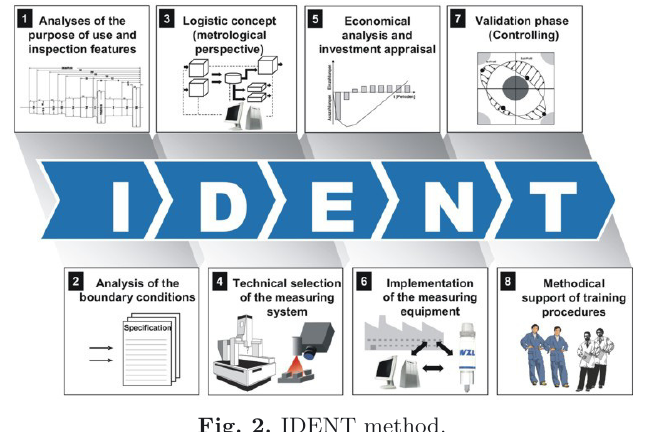
Fig. 2. IDENT method.